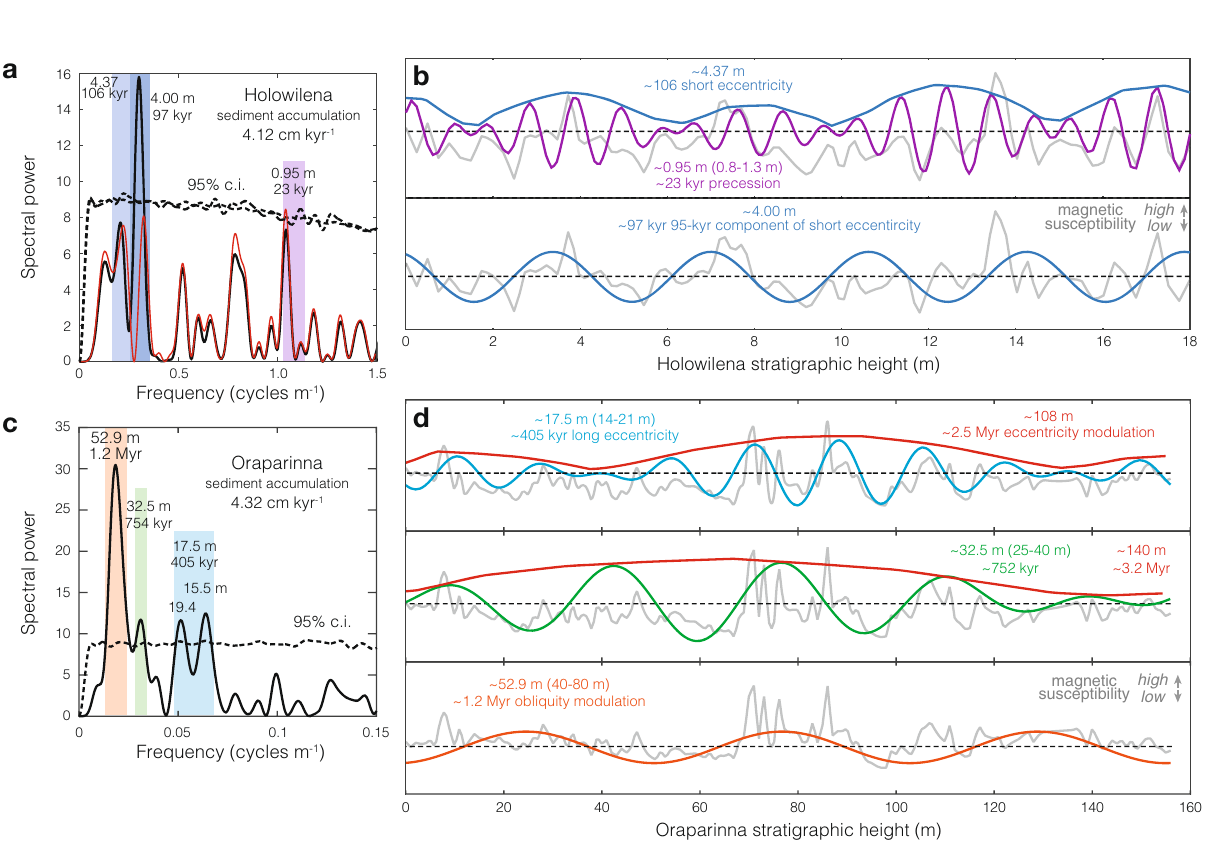
Fig. 3 Time series analysis of iron formation. a Fast-Fourier transform (FFT) of magnetic susceptibility at Holowilena. Red spectra are FFT recomputed after subtracting the strongest signal (~4 m; ~97 kyr). Two distinct signals in the ~100 kyr bandwidth are shown as two overlapping transparent dark blue bands. b Bandpass fi lters of signi fi cant cycles identi fi ed with FFT at Holowilena. Raw magnetic susceptibility data are shown in gray. c FFT of magnetic susceptibility at Oraparinna. d Bandpass fi lters of signi fi cant cycles identi fi ed with FFT at Oraparinna. Envelopes of bandpass fi lters exhibiting amplitude modulation characterized using the Hilbert transform (Methods). Raw detrended data are shown as the gray line.